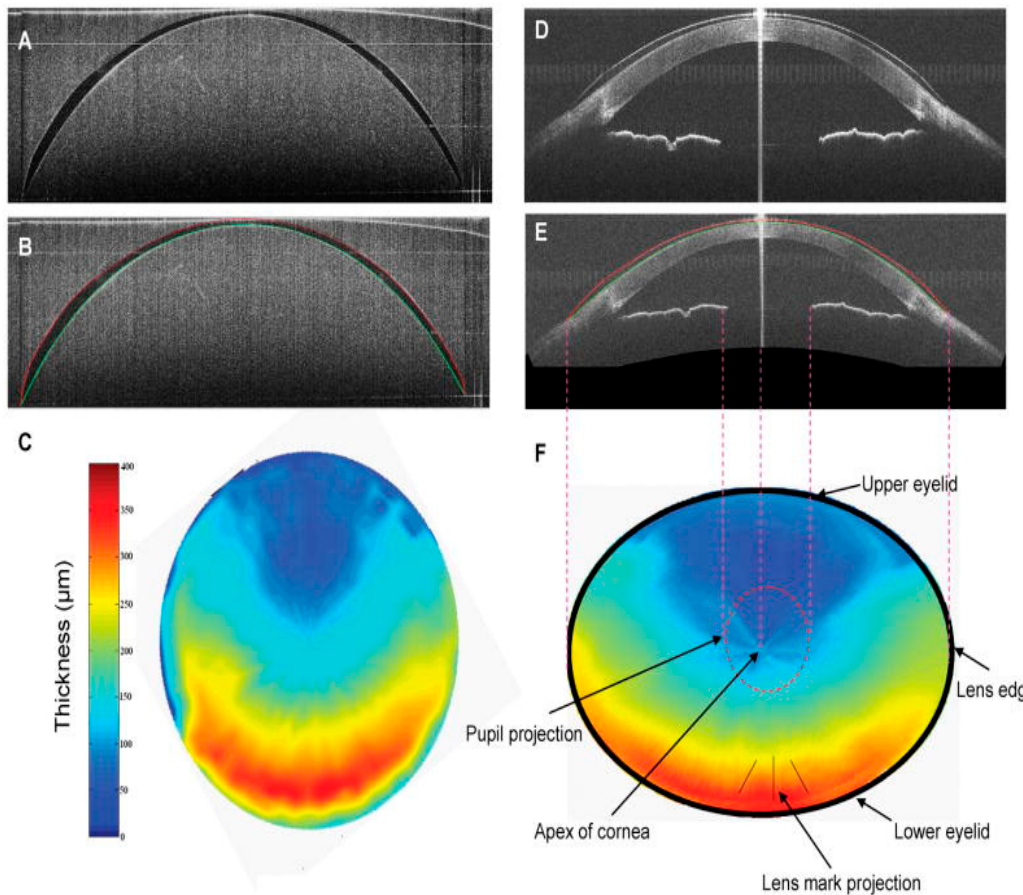
Figure 5. The whole area of a CL in vitro and on the ocular surface imaged by SOCT. Cross-sectional OCT image of a toric soft CL immersed in CL solution ( A ) and in vivo ( D ) and their segmented surfaces: anterior in red and posterior in green can be seen in ( B ) and ( E ), respectively. The thickness map of the toric soft CL is the same in vivo ( F ) and in vitro ( C ). The resolution is ~6.0 µm axially and ~15.0 µm transversally. Adapted from Shen et al. [28].